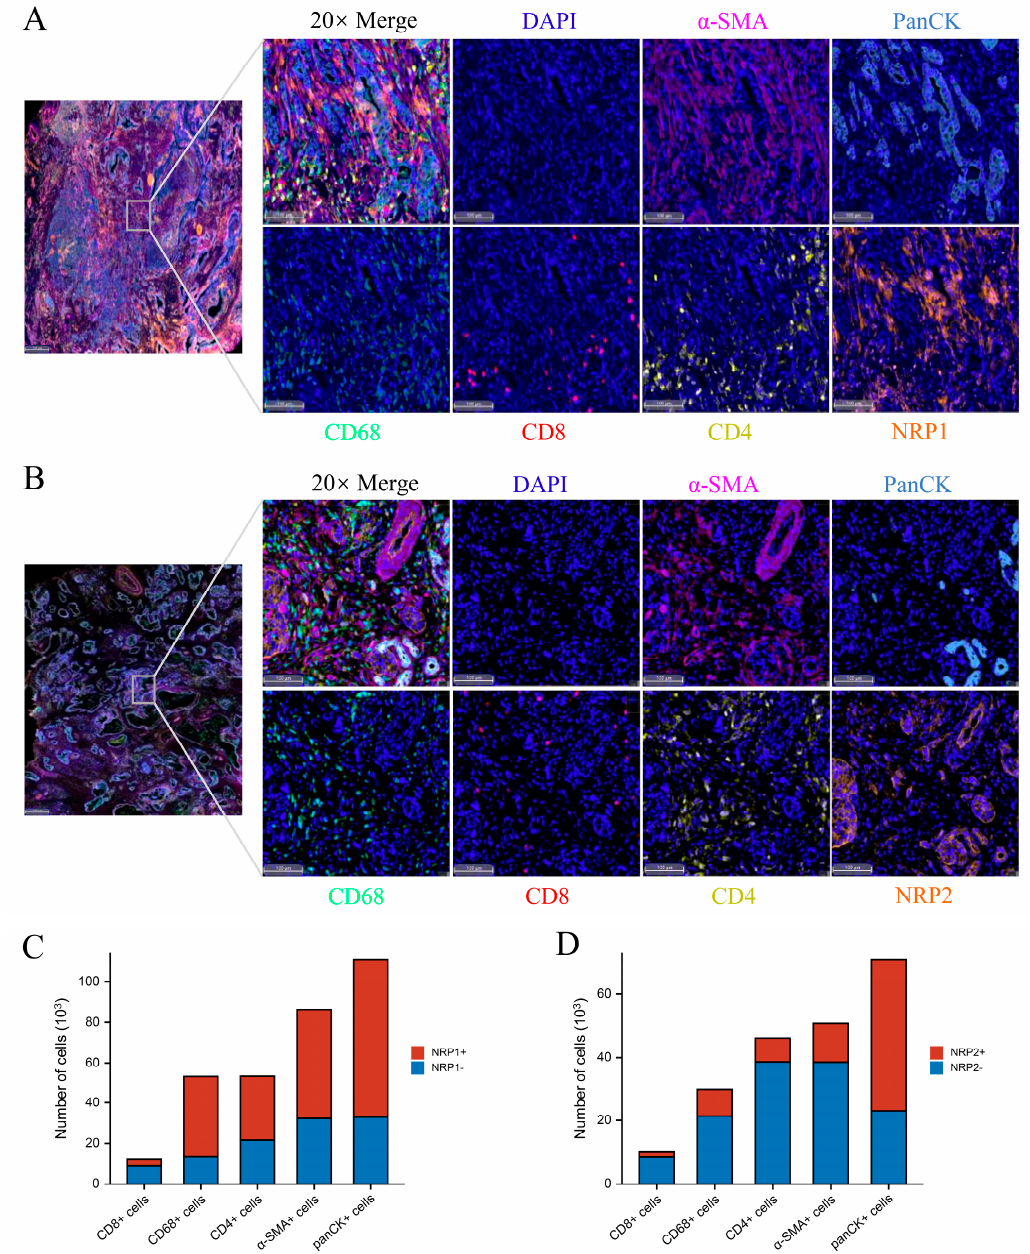
Figure 2. NRP expression in PAAD tumor microenvironment. ( A , B ) The representative results of multiplexed immunohistochemistry in PAAD tumor microenvironment. scale bars 100 μ m. ( C , D ) The statistical results of NRP protein expression in various cells.